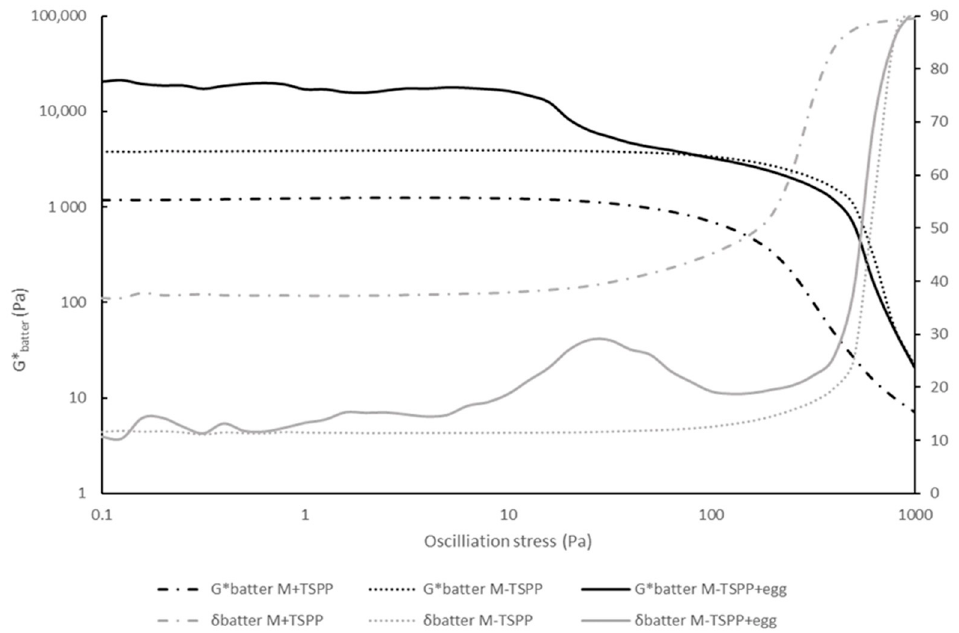
Figure A1. Stress sweep curves of meat batters containing phosphate (M+TSPP, dash-dot line), without phosphate (M-TSPP, dotted line), and without phosphate-containing egg white proteins (M-TSPP+egg, full line). The complex modulus (G*, black color) and phase angle ( δ , grey color) are displayed on the primary and secondary y-axis, respectively. Confidence intervals are not included to enhance the readability of the graph (n = 2).